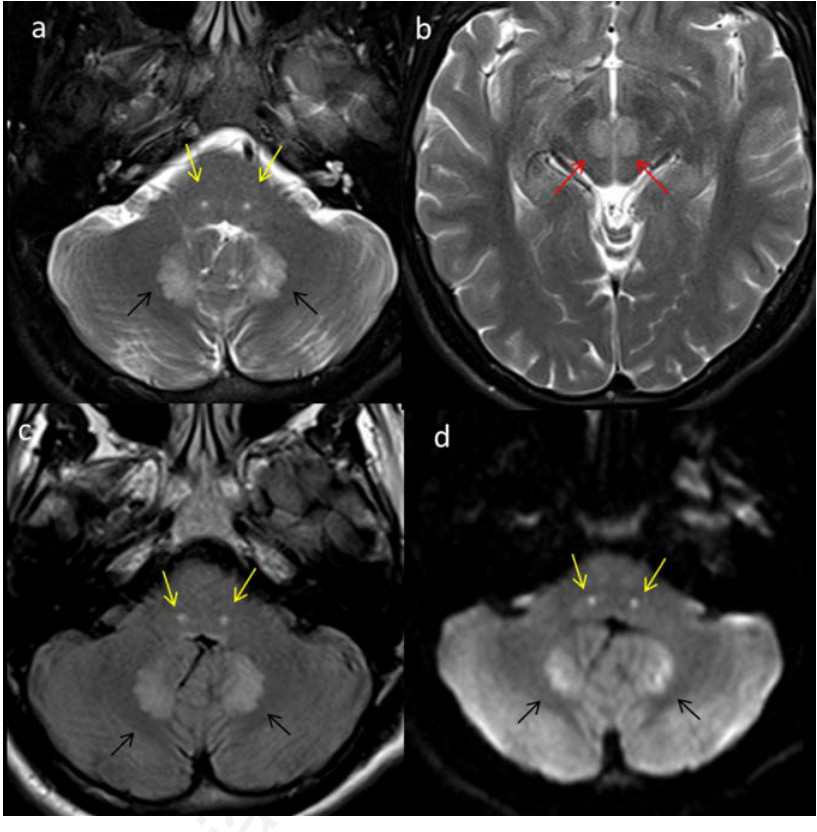
Figure 1. Multiple axial magnetic resonance imaging of the brain in a 22-year old male on metronidazole presenting with cerebellar symptoms. Axial T2 images (a,b) reveal sym- metric areas of increased signal in the dentate (black arrows), the facial (yellow arrows) and the red nuclei (red arrows), bilaterally. Axial fluid attenuated inversion recovery images (c) showing similar changes with restricted diffusion noted on the diffusion- weighted image (d).